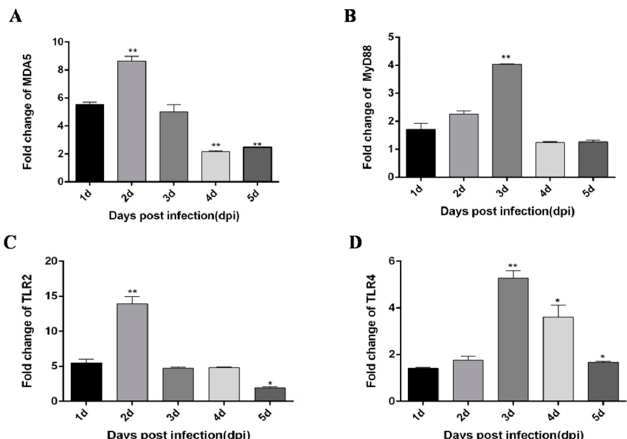
Figure 4. DTMUV-infected ducks effectively up-regulate MDA5, MD88, TLR2, and TLR4 expression in the liver. Each young SPF duck was challenged by intramuscular inoculation with DTMUV. ( A – D ) Liver tissues of mock- and DTMUV-infected ducklings were collected at the indicated time points for examination of MDA5 ( A ), MyD88 ( B ), TLR2 ( C ), and TLR4 ( D ) mRNA expression using qRT-PCR. The average levels from three independent experiments are plotted. The error bars represent the SEs. * P < 0.05, ** P < 0.01.